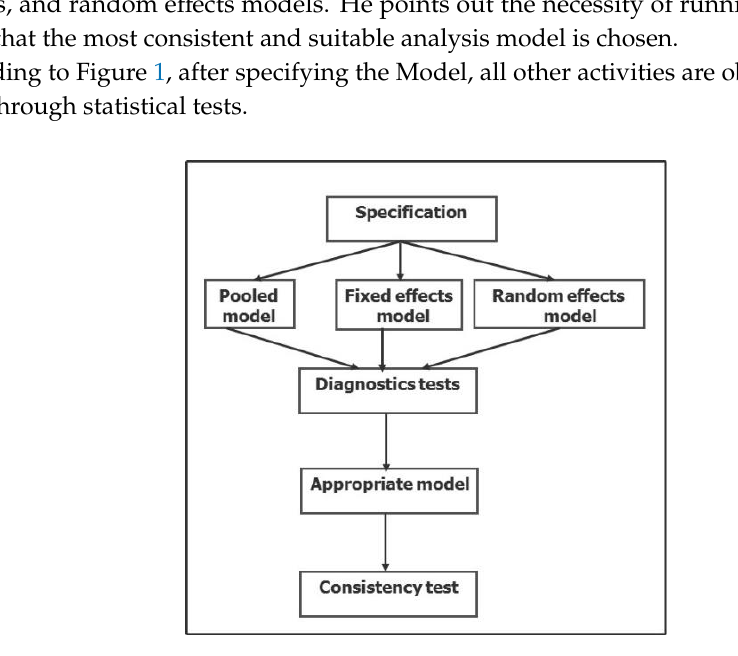
Table 4. Tests to choose the best panel regression model.